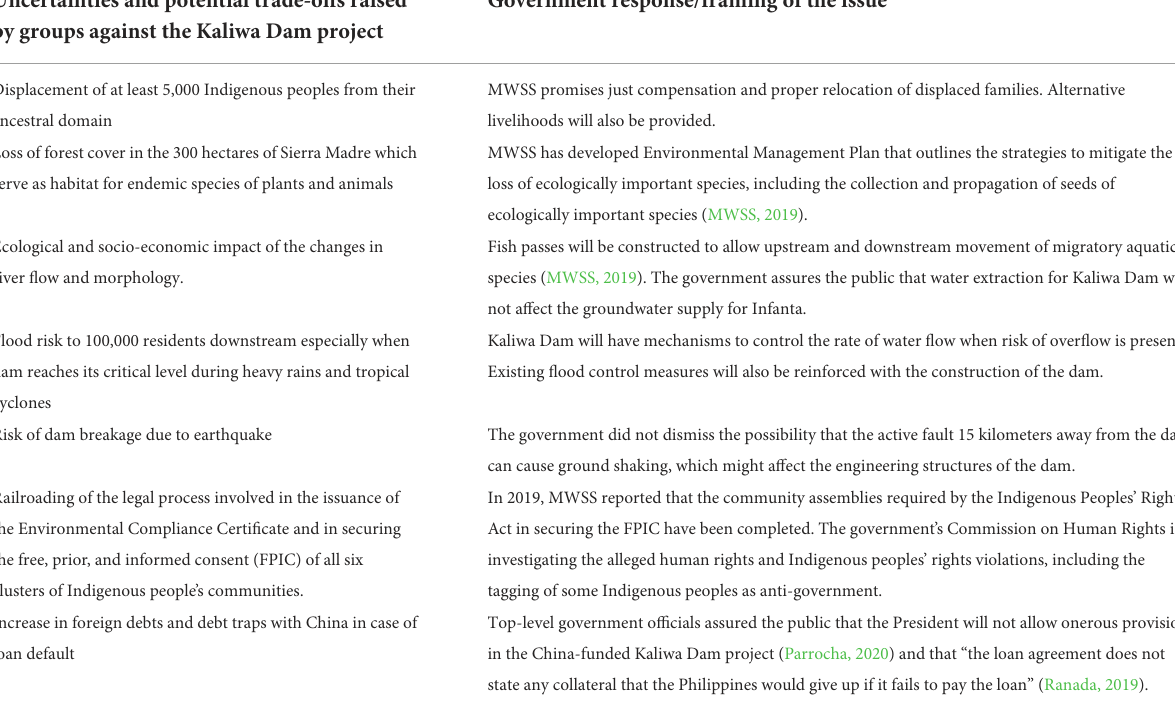
TABLE 1 Uncertainties and trade-offs raised by anti-Kaliwa Dam social movements and the corresponding government response and framing of the issues. Uncertainties and potential trade-offs raised by groups against the Kaliwa Dam